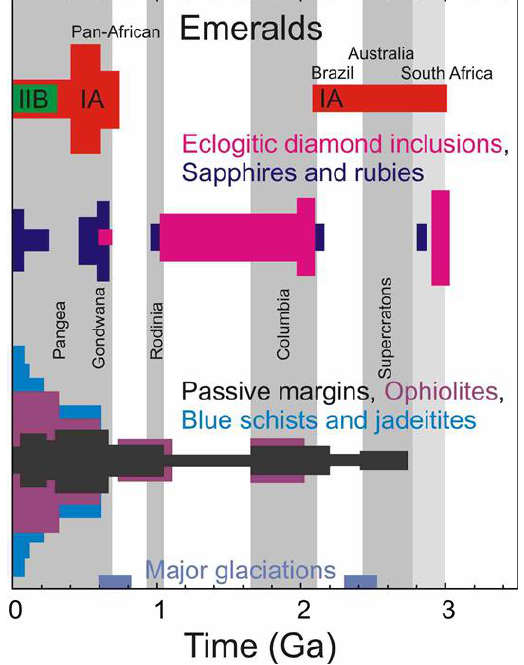
Figure 9. Example of the relations of emeralds and other indicators of plate tectonics with time. Distributions are shown as relative abundances of deposits for emeralds, or as relative distributions from histograms for passive margin distribution [55], eclogitic diamond inclusions [54], and blue schists, lawsonite, jadeitite, ophiolites, sapphires and rubies [52]. Additionally, shown are major supercontinent episodes (Supercratons, Columbia, Rodinia, Gondwana and Pangea) and onset of continent formation, as well as major glaciations [56]. Sedimentary lubrication events following major glaciations have been inferred by the latter study. Emerald age compilation is given in the Supplementary Information.